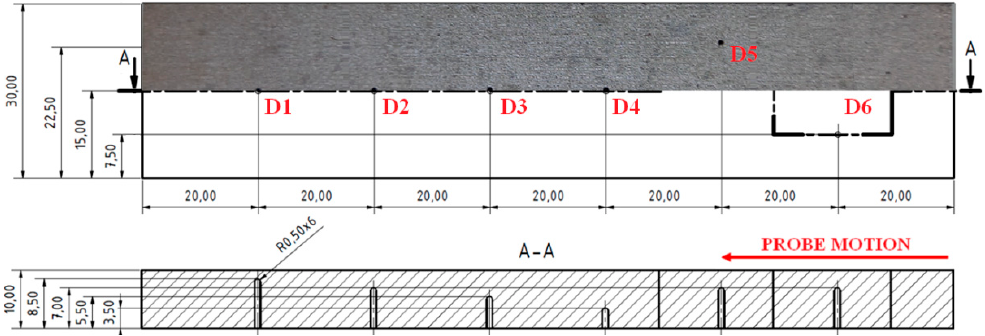
Figure 15. S4 sample.